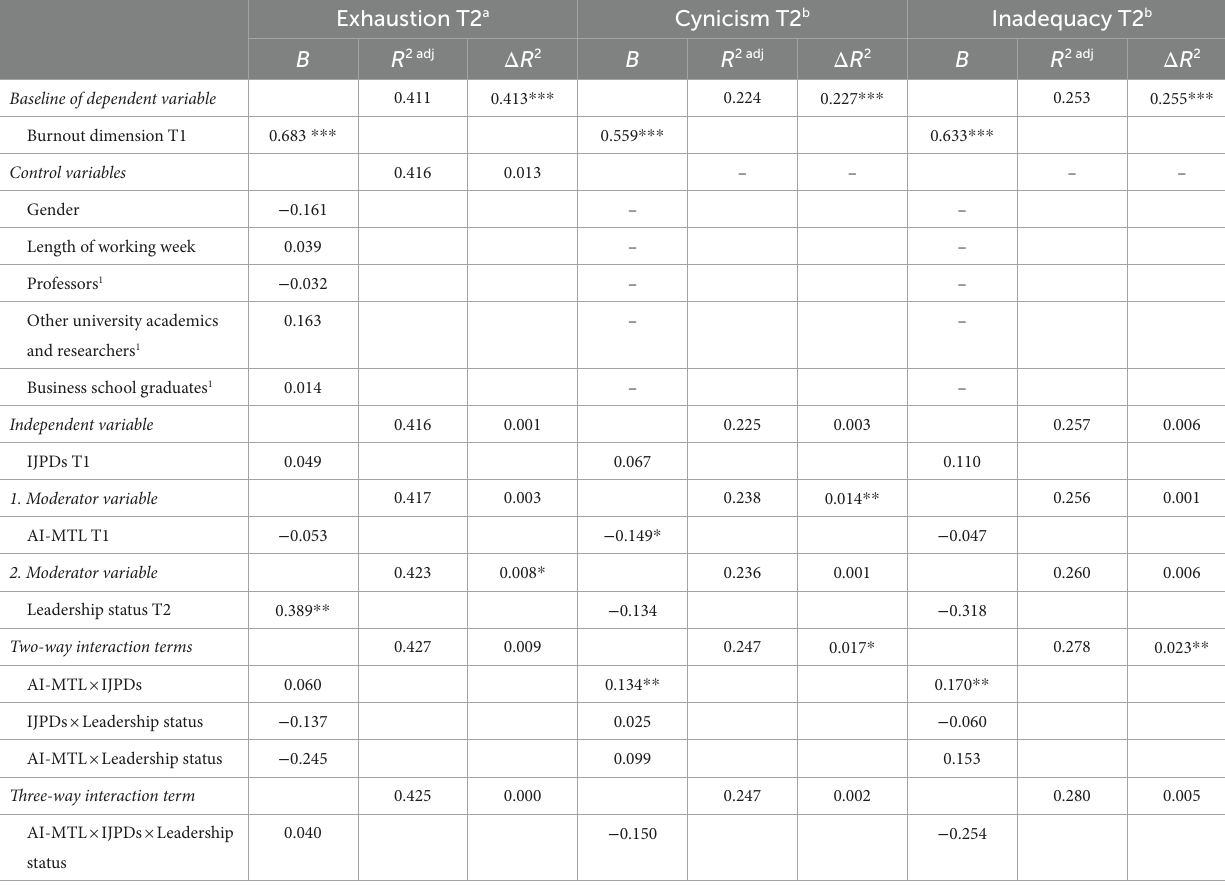
TABLE 2 The longitudinal associations between intensified job-related planning demands (IJPDs) and burnout (exhaustion, cynicism, and inadequacy) moderated by affective-identity motivation to lead (AI-MTL) and leadership